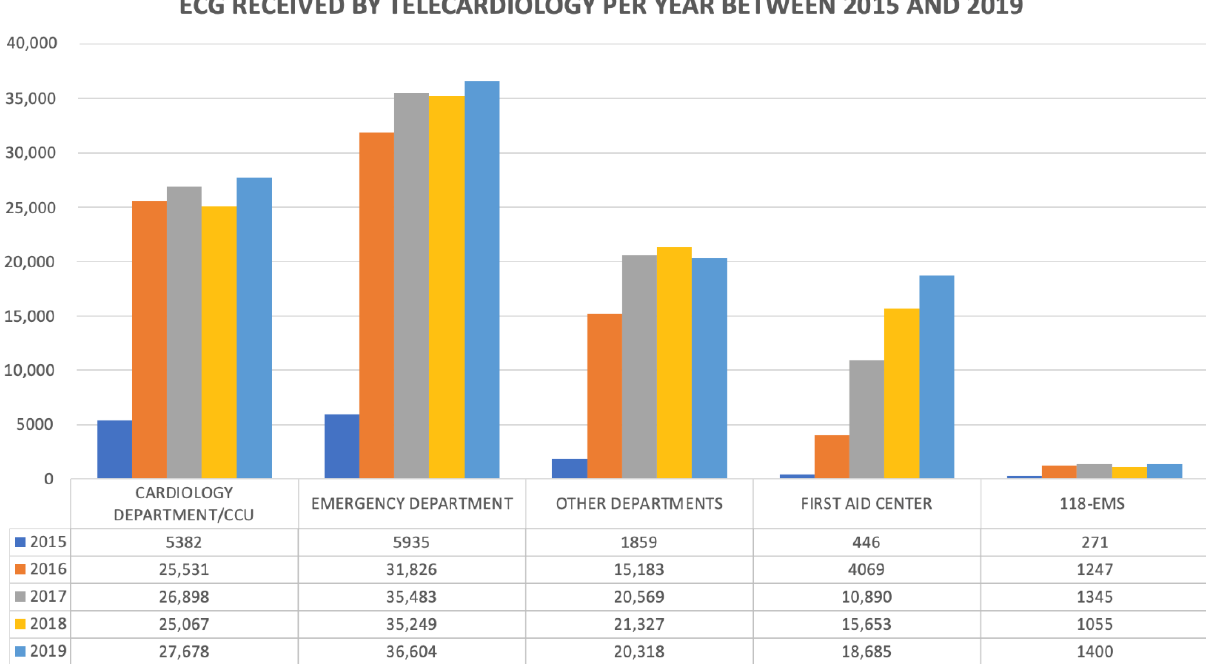
Figure 1. ECGs received by telecardiology per year between 2015 and 2019.